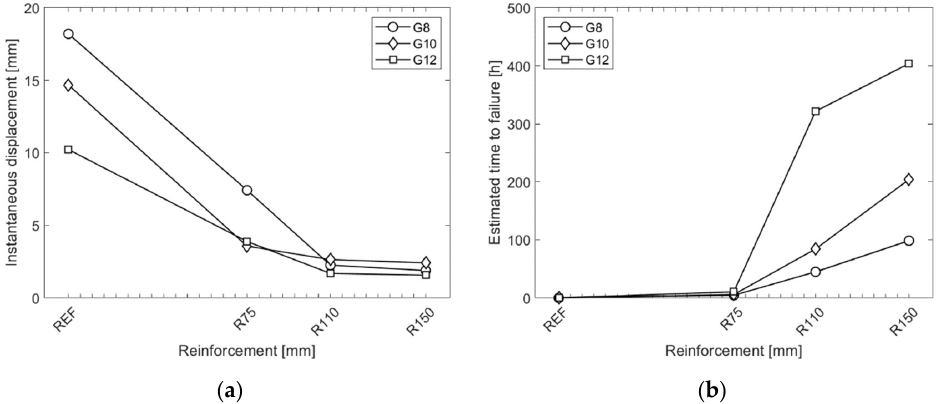
Figure 11. Results of creep experiments: ( a ) instantaneous displacement after constant force; ( b ) estimated time to failure.